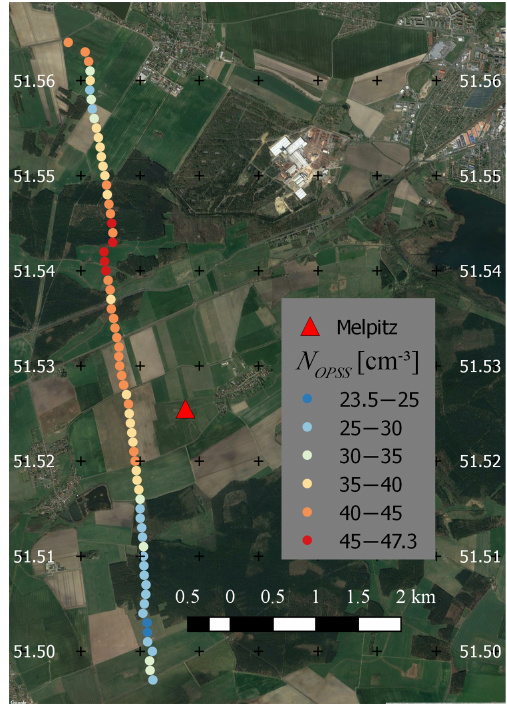
Figure 9. Horizontal distribution of the mean PNC ( N OPSS ) for particles with an optical diameter of 356nm to 2.8µm within layer of 950 to 1050m aboveground recorded between 13:06 and 13:34UTC on 14 September (legs D and F of flight 14b). The more reddish the symbol the higher is the concentration. The red triangle represents the measurement site in